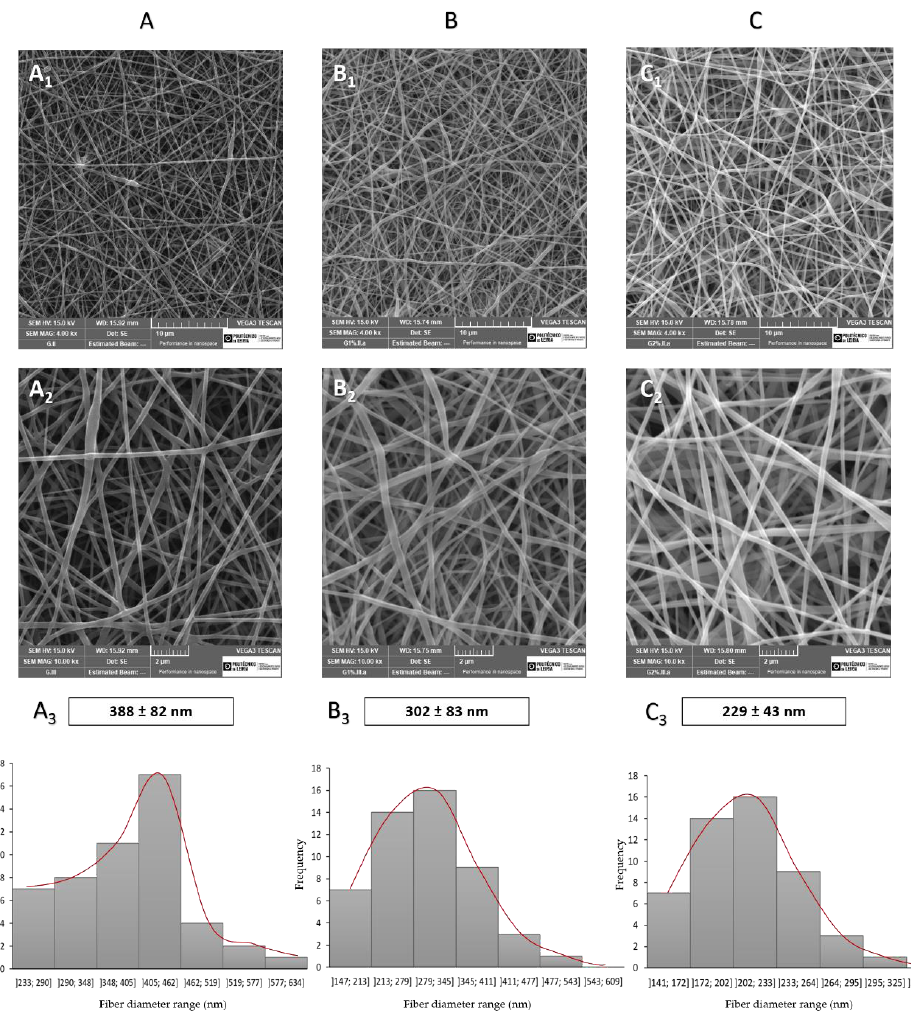
Figure 1. Scanning electron microscopy morphological assessment of electrospun meshes. ( A ) WOE electrospun meshes at ( A 1 ) 4000 × and ( A 2 ) 10,000 × of magnification and respective average fiber diameters with the distribution curve ( A 3 ); ( B ) WE1 electrospun meshes at ( B 1 ) 4000 × and ( B 2 ) 10,000 × of magnification and respective average fiber diameters with the distribution curve (B 3 ); ( C ) WE2 electrospun meshes at 4000 × ( C 1 ) and 10,000 × of magnification ( C 2 ), and respective average fiber diameters with the distribution curve ( C 3